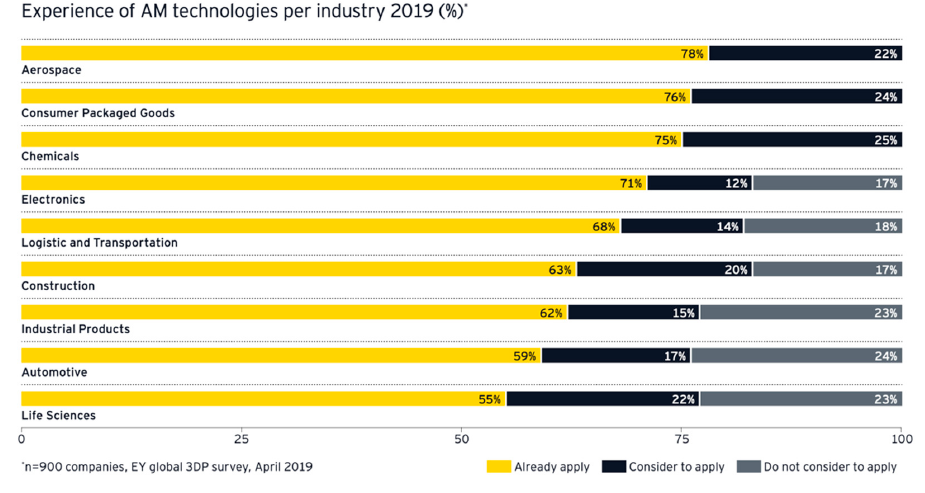
Figure 6. Experience of additive manufacturing (AM) technologies per industry [33].